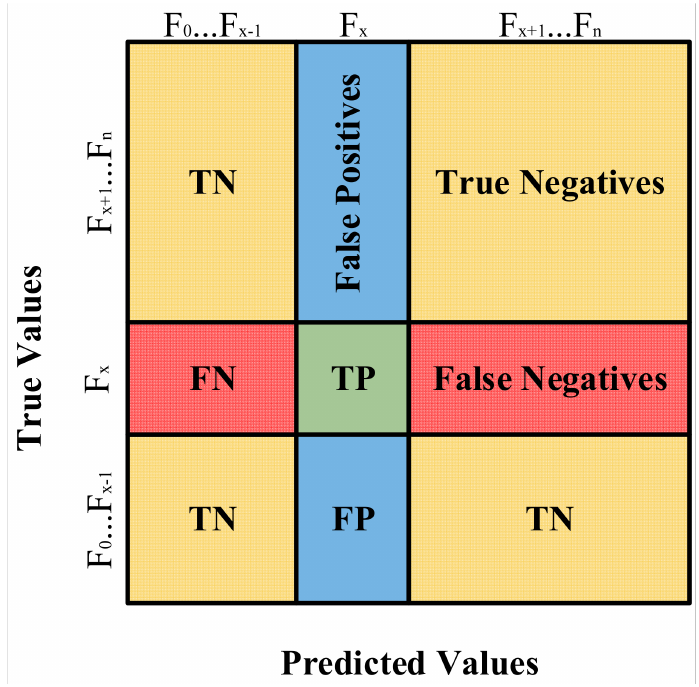
Figure 6. Classification confusion